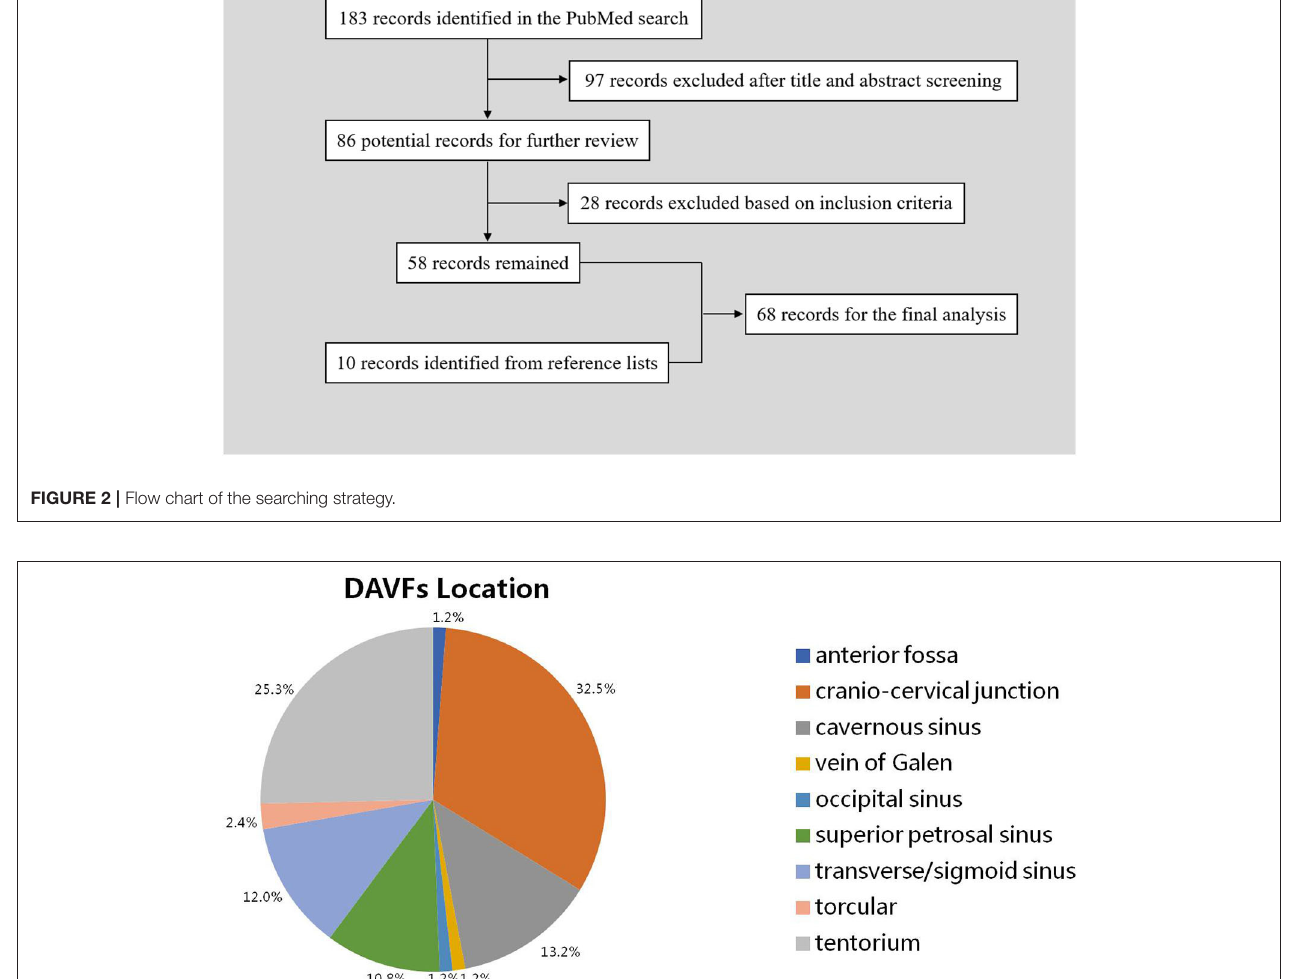
hyper, hypo, and normal intensity could be in 1 (10%), 3